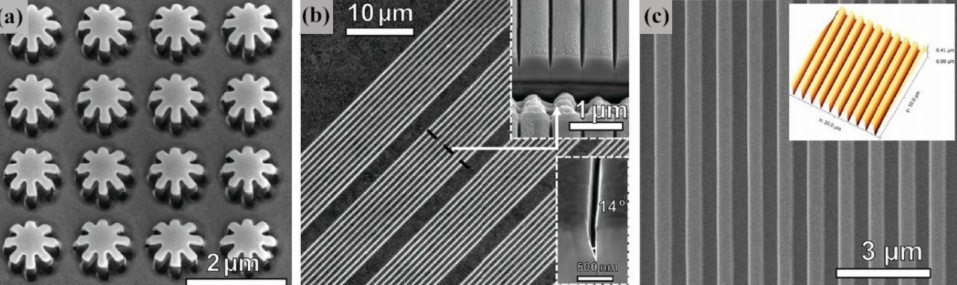
Figure 17. The SEM images of several complex 3D nanostructures manufactured with LSI. ( a ) Array of nanogears imprinted on cold-rolled aluminum foil; ( b ) array of triangular V-grooves; ( c ) array of the ultrasmooth nanotrenches fabricated on the Ti surface layer with the thickness of 2.5 mm.